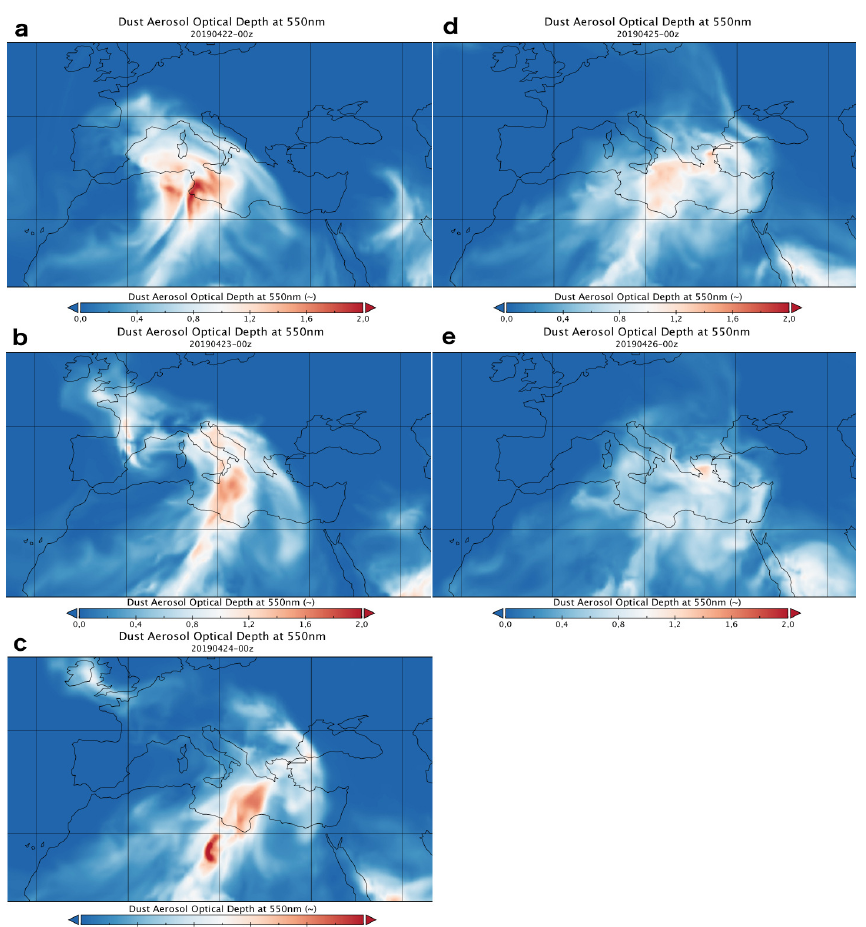
Figure 13. Dust AOD at 550 nm, from 00 UTC on 26 April to 00 UTC on 26th on April every 24 h. The maps ( a – e ) are generated using Copernicus Atmosphere Monitoring Service Information (2015–2019).